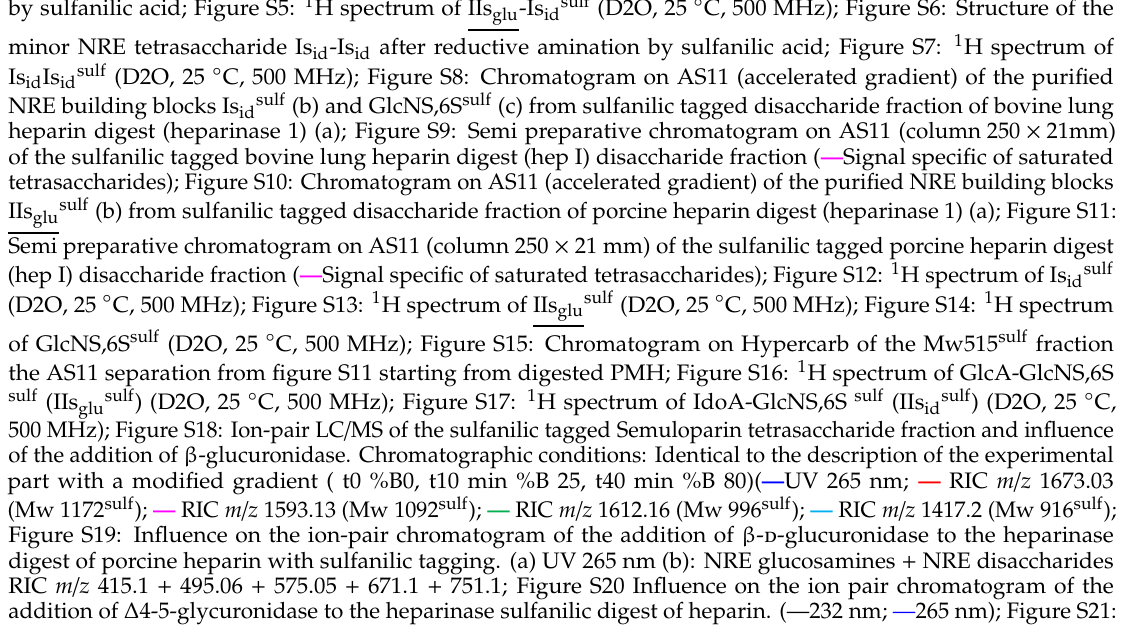
Figure S19: Influence on the ion-pair chromatogram of the addition of β - d -glucuronidase to the heparinase digest of porcine heparin with sulfanilic tagging. (a) UV 265 nm (b): NRE glucosamines + NRE disaccharides RIC m / z 415.1 + 495.06 + 575.05 + 671.1 + 751.1; Figure S20 Influence on the ion pair chromatogram of